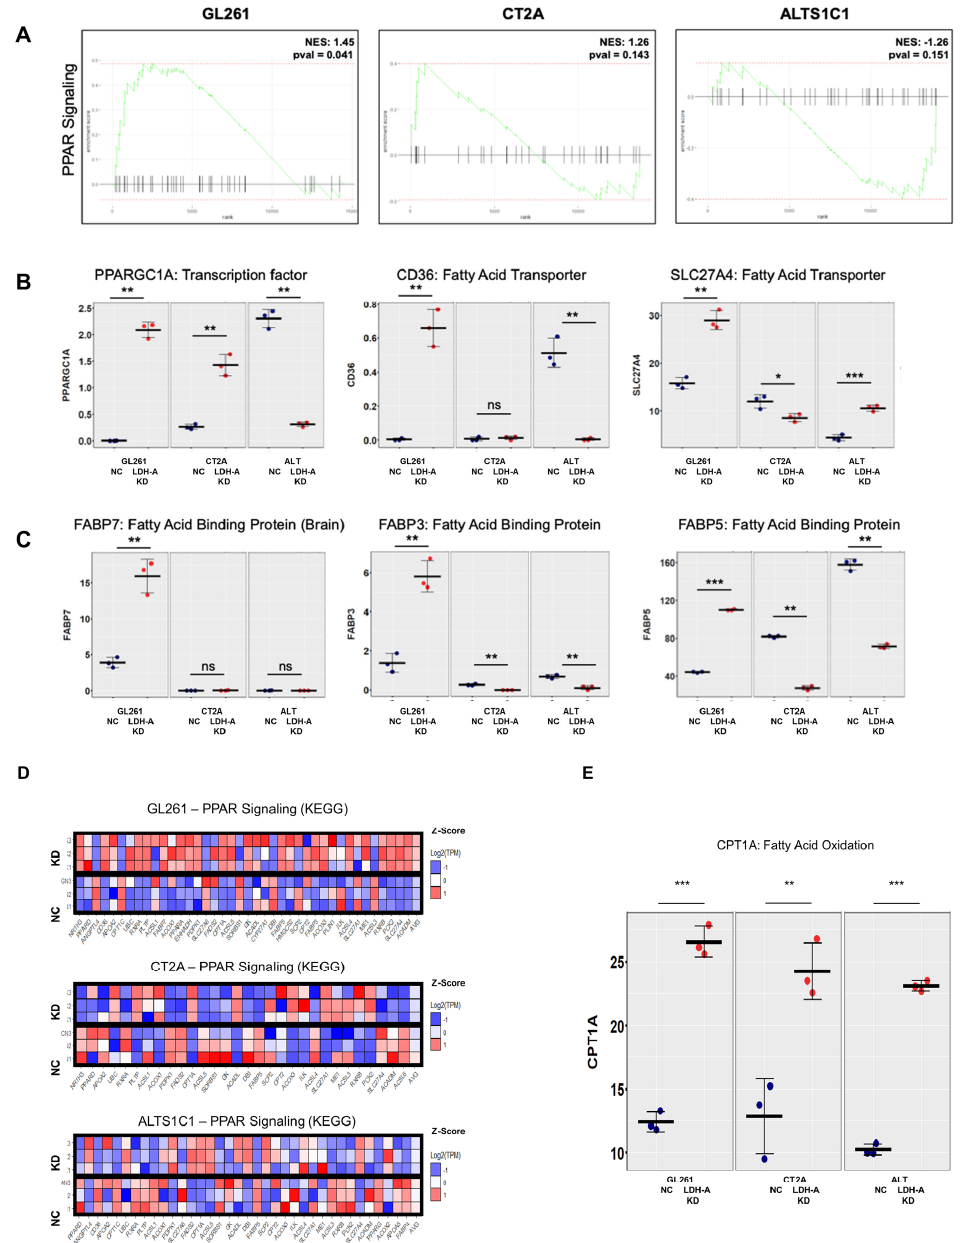
Figure 3. Overexpression of genes involved in lipid metabolism in GL261 LDH-A KD cells. A Gene Set Enrichment Analysis (GSEA) for a single pathway (Peroxisome proliferator-activated receptor (PPAR) pathway) is shown for each GBM cell line ( A ). Transcripts per million (TPM) expression values were plotted in individual cell lines for genes directly involved in PPAR pathway, showing significant upregulation of these genes in ( B ). The Z-transformed scores of individual genes within the PPAR pathway were plotted across each GBM cell line (GL261, CT2A and ALTS1C1). The experiment performed with triplicates, with rows representing each sample, and columns representing individual genes, shows the greatest enrichment in GL261 LDH-A KD cells ( C ). Expression (TPM) of carnitine palmitoyltransferase I (CPT1A) is shown for each cell line ( D ). CPT1A is a mitochondrial enzyme that allows for subsequent movement of acyl carnitine from the cytosol into the intermembrane space of mitochondria, playing an important role in fatty-acid metabolism. Significant differences are indicated by: * p < 0.05, ** p < 0.01, and *** p < 0.001. ( D , E ) Overexpression of genes involved in lipid metabolism (PPAR signaling pathway) in LDHA KD glioma cells. Table S4 of the Supplement provides the semi-raw data from the RNASeq analysis that was used to generate the